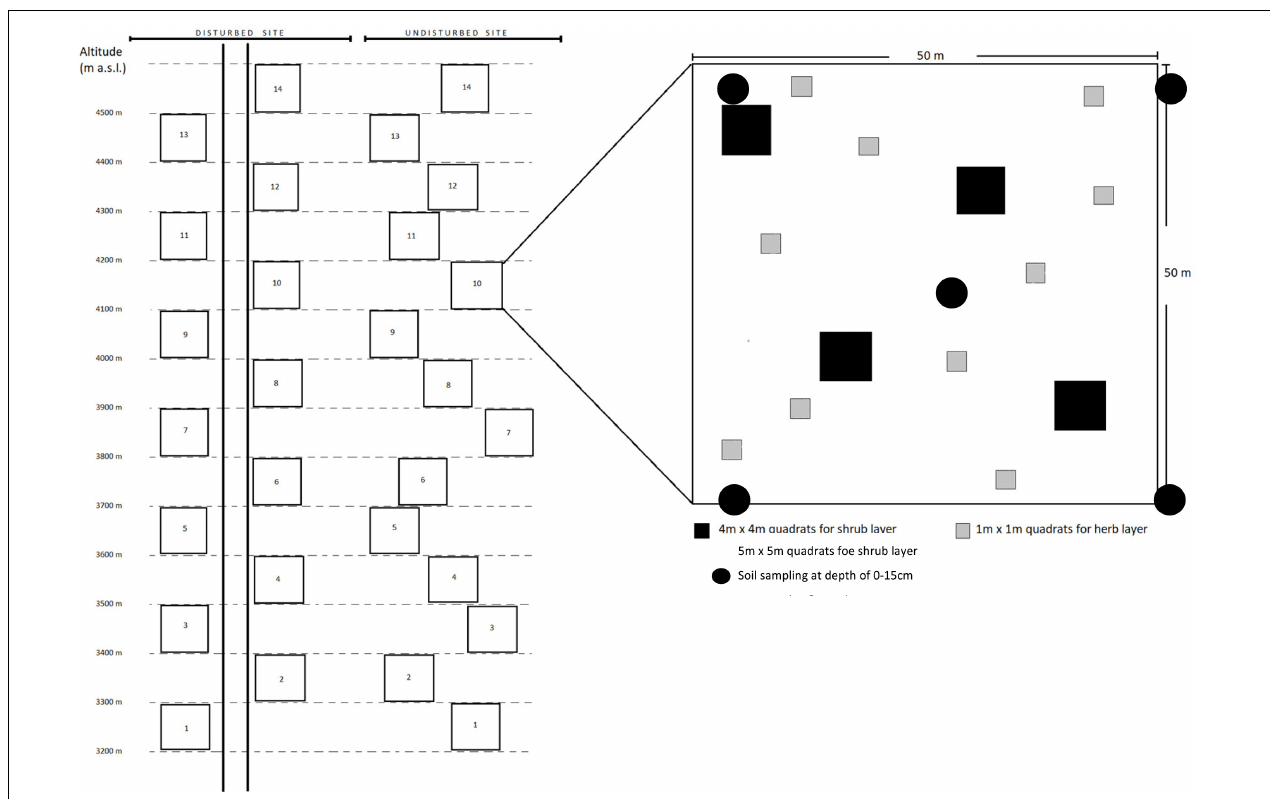
FIGURE 1 | Sampling design. Schematic illustration of the two study sites, i.e., disturbed and undisturbed, along an altitude gradient from 3,200 to 4,500 m with a sample plot of 0.25 hac (50 m × 50 m) in each altitudinal zone. Plot design (right) is equivalent on each plot.